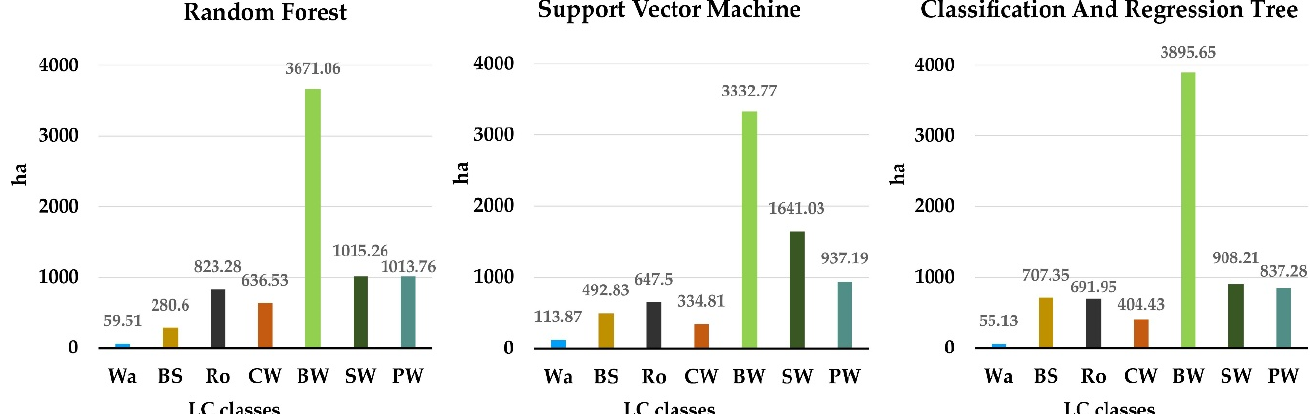
Figure 3. Total classified surface for each adopted classifier (RF: random forest; SVM: support vector machine; CART: